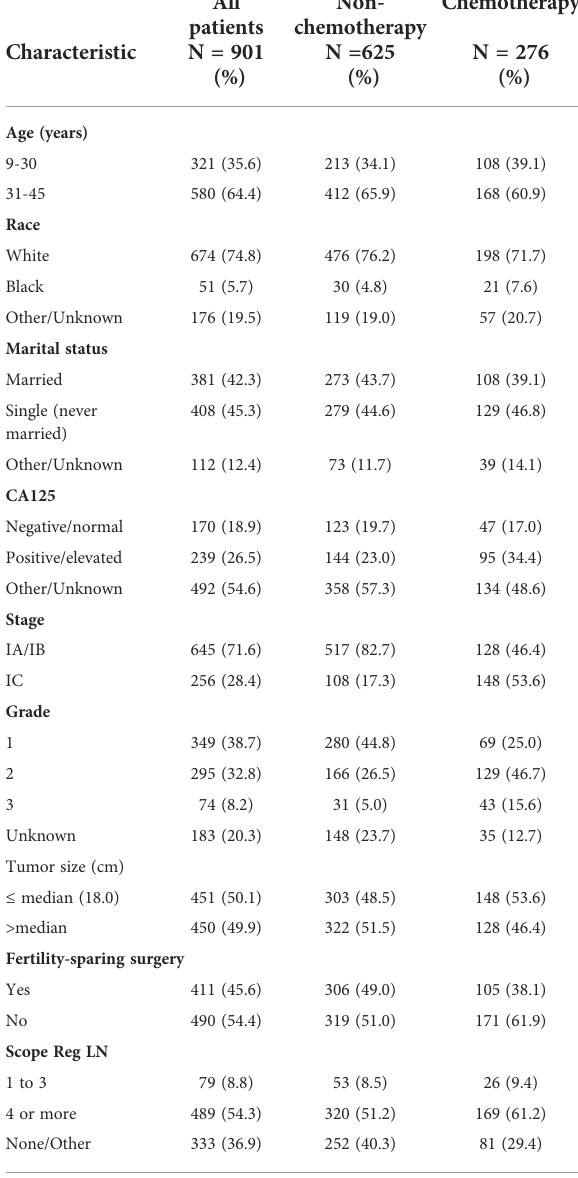
TABLE 1 Summary of demographic, surgical pathologic, and treatment information for stage I